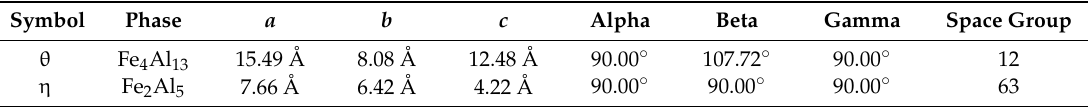
Figure 10. IMC layer microstructures at the interface of the Al/steel butt joints with different travel speeds: ( a ) 0.6 m/min; ( b ) 0.8 m/min; ( c ) 1.0 m/min; ( d ) 1.1 m/min; ( e ) 1.2 m/min; ( f ) thickness of the IMC layers (contained in the second panel).